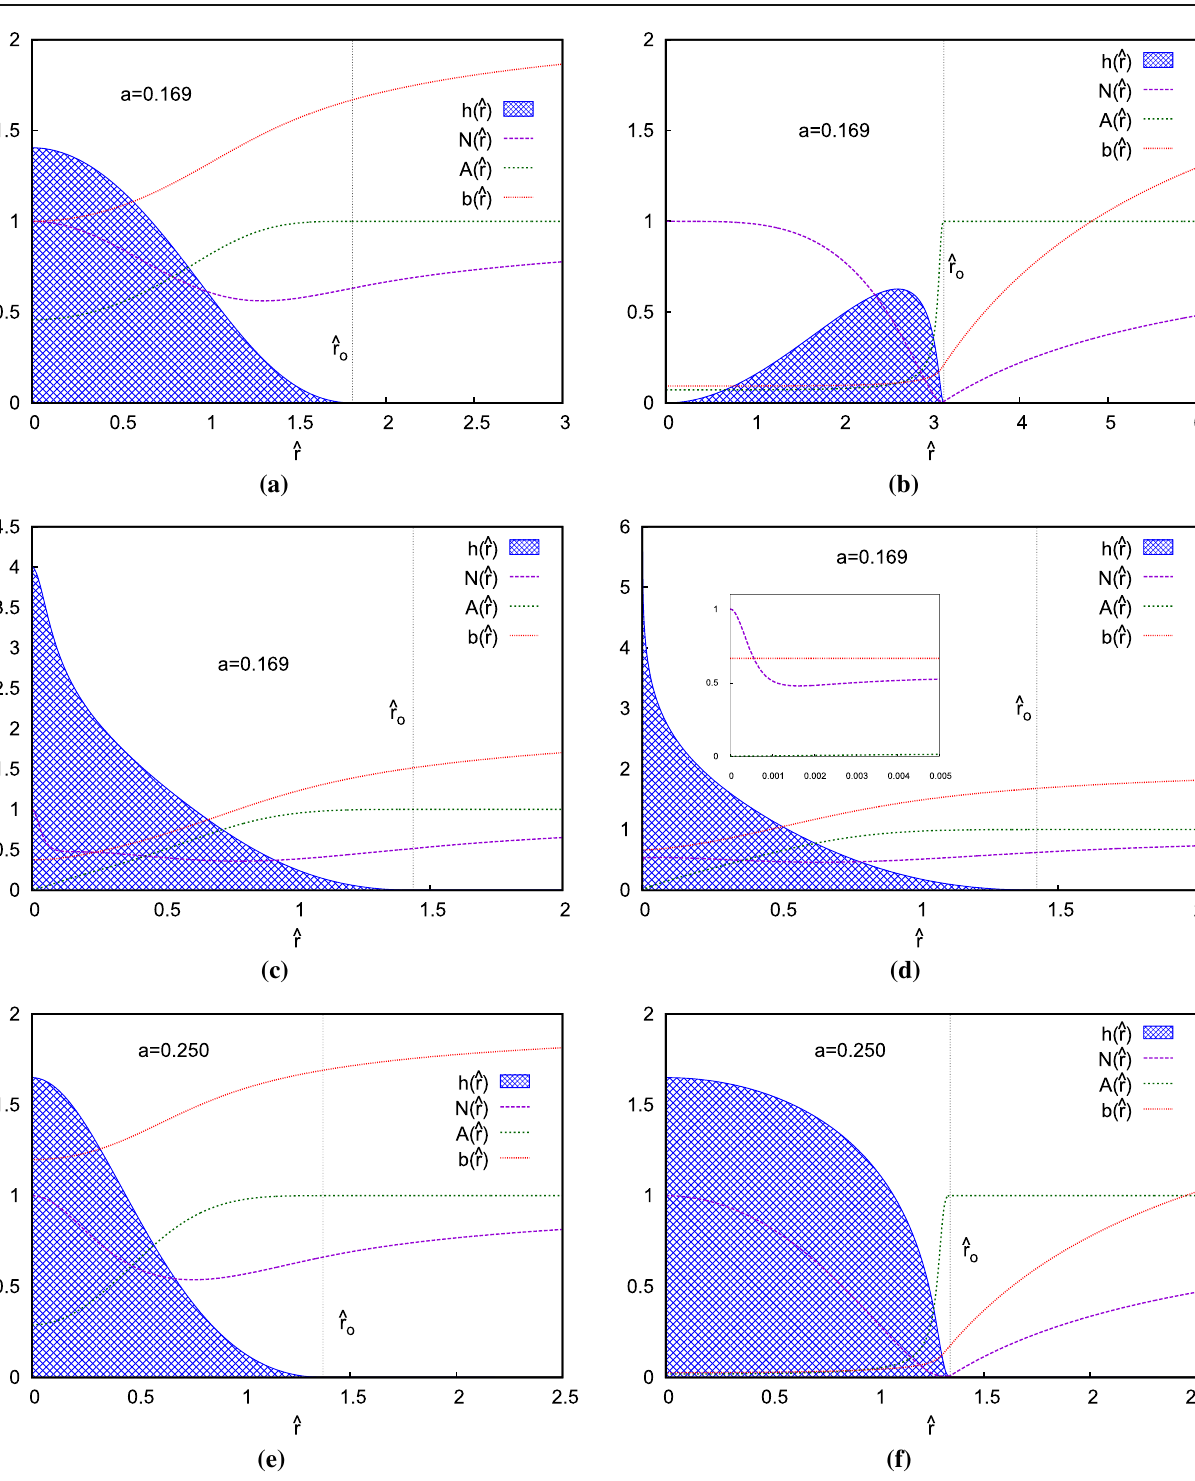
denoted by P 1 (IA), P 2 (IA transition to shells), P 3 (IB2) and P 4 (IB3), which lie on the phase trajectory corresponding to a = 0 . 169, and e , f correspond to the representative points denoted by P 5 (IIA) and P 6 (IIB), which lie on the phase trajectory corresponding to a = 0 .